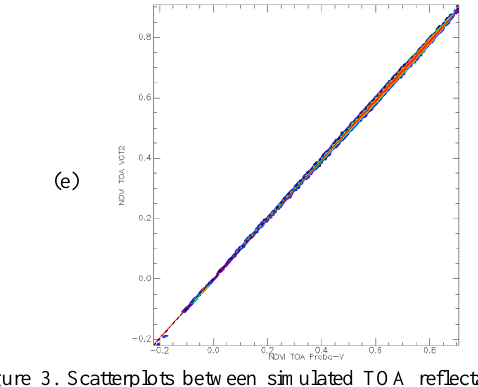
Figure 3. Scatterplots between simulated TOA reflectances of PROBA-V and VGT-2 for (a) Blue; (b) Red; (c) NIR; (d) SWIR; (e) NDVI